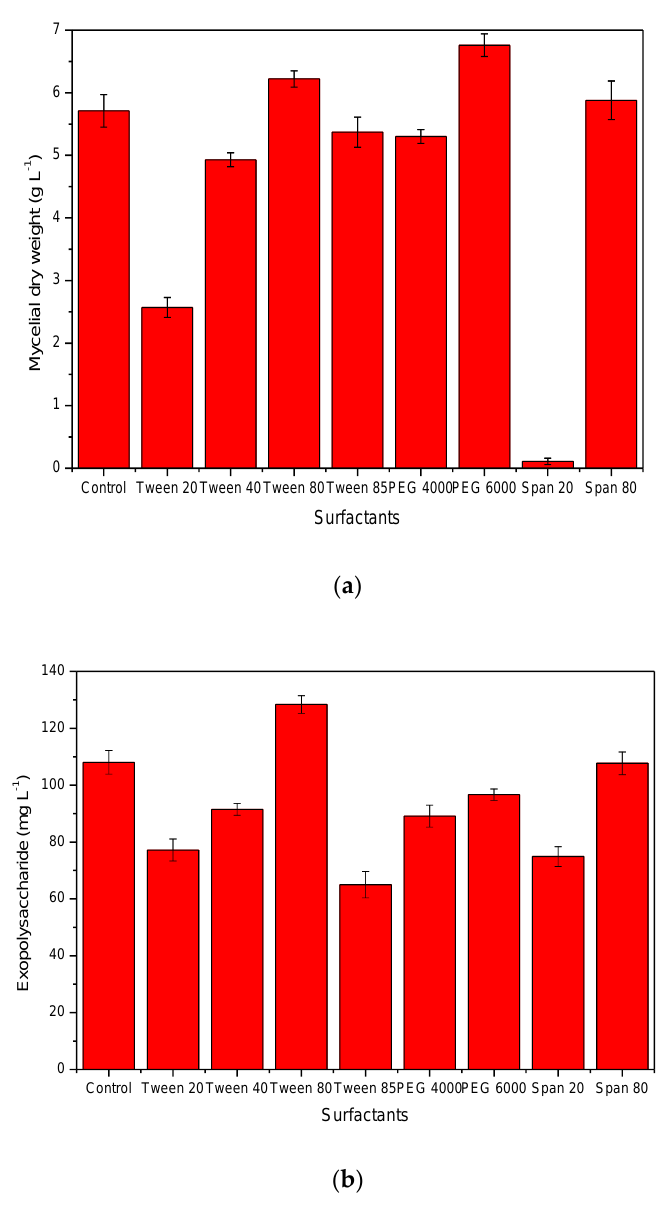
Figure 1. The effects of various surfactants on mycelia growth ( a ) and EPS production ( b ) in shake − flask cultures.